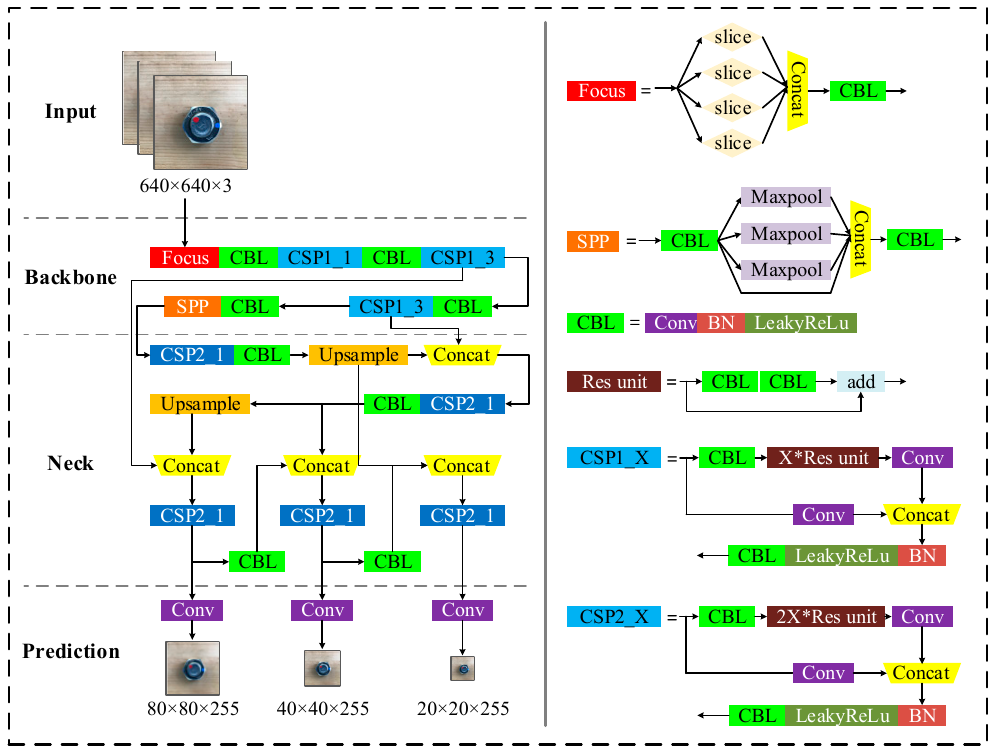
Figure 3. YOLOv5 network structure.